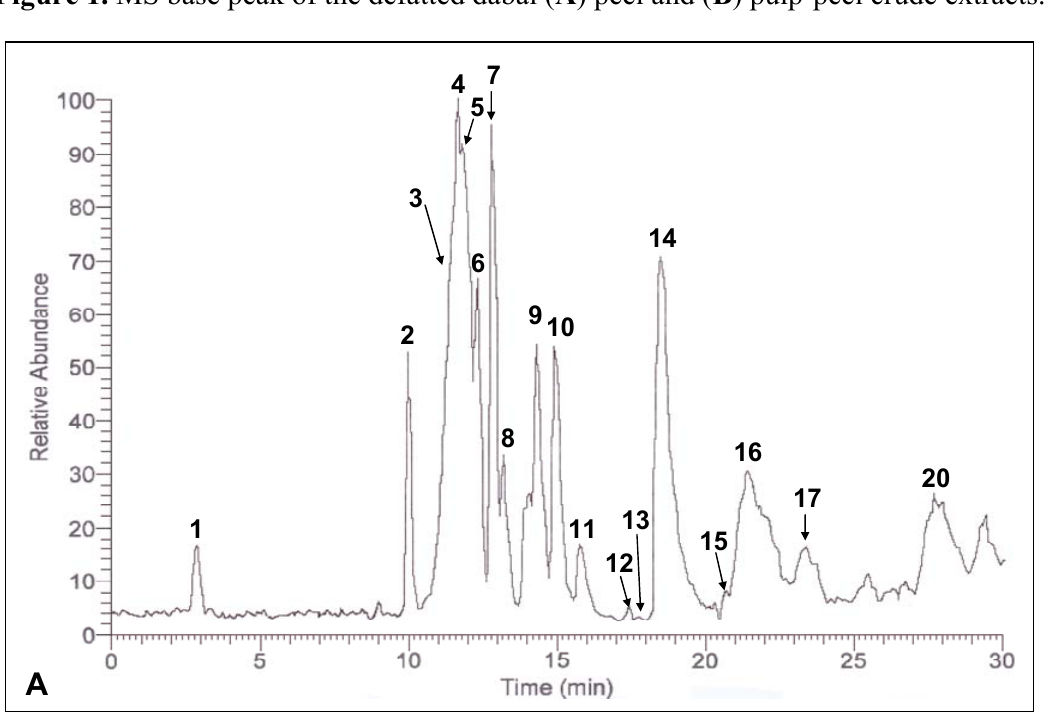
Figure 1. MS base peak of the defatted dabai ( A ) peel and ( B ) pulp-peel crude